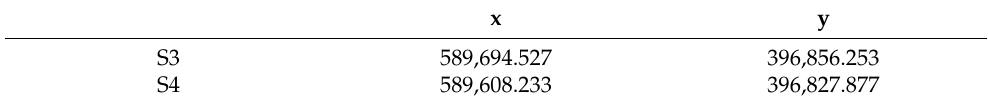
Table A3. Approximate coordinates of S3 and